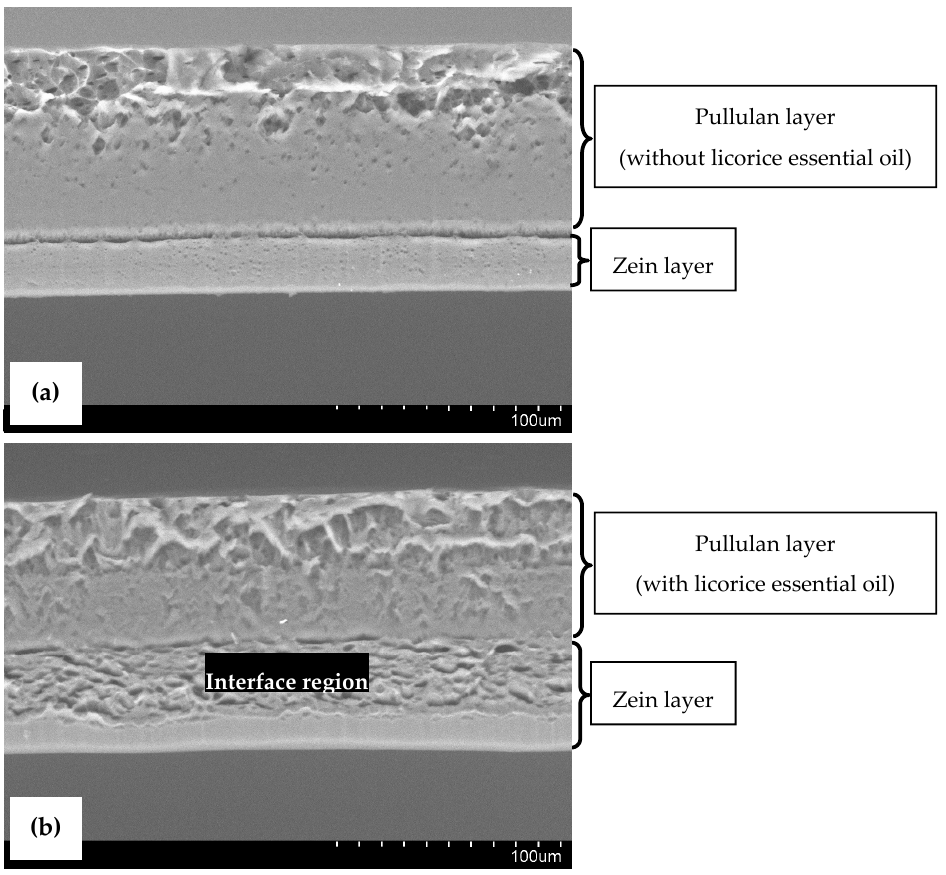
Figure 2. Scanning Electron Microscopy (SEM) images of cross-sections of bilayer control film ( a ), and bilayer film incorporating licorice essential oil ( b ). (Magnification: 500×).